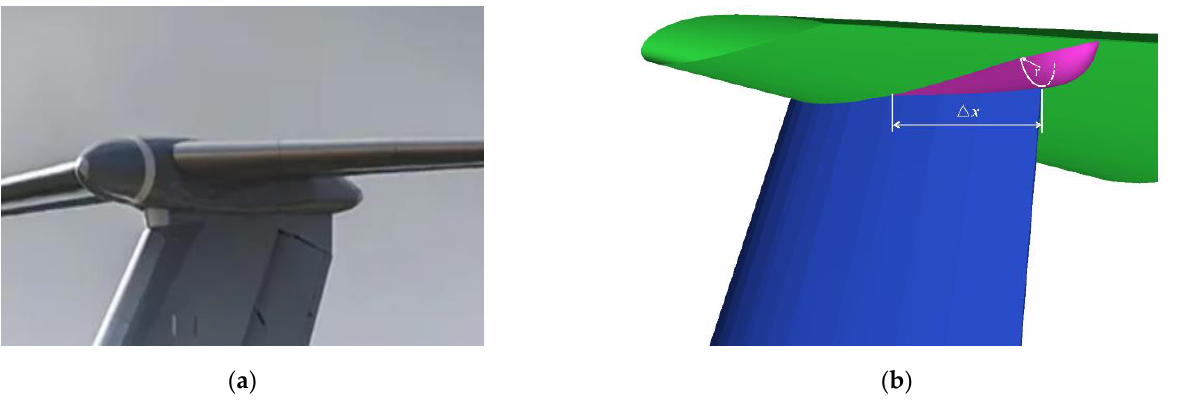
Figure 15. Two different fairing-cone models: ( a ) bullet fairing cone; ( b ) schematic of the fairing cone model used herein.